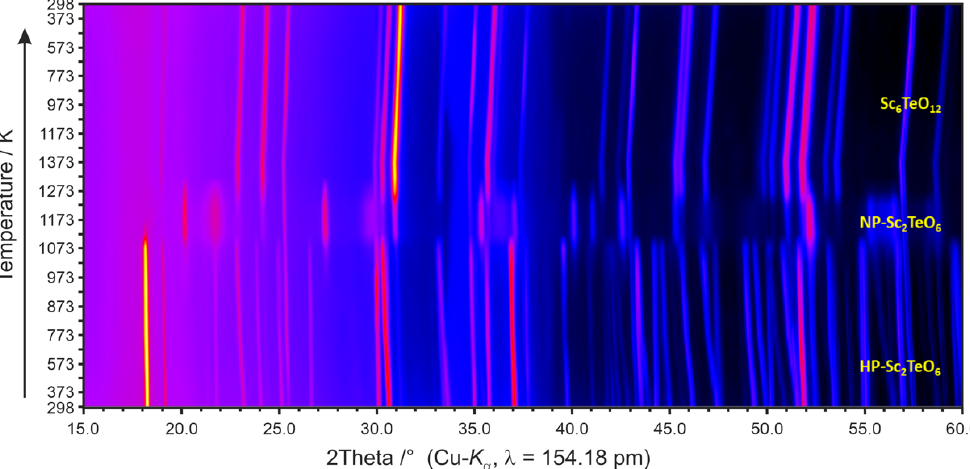
Figure 5. Temperature-dependent X-ray powder diffractogram displaying the back-transformation of HP-Sc 2 TeO 6 to the ambient pressure modification NP-Sc 2 TeO 6 .